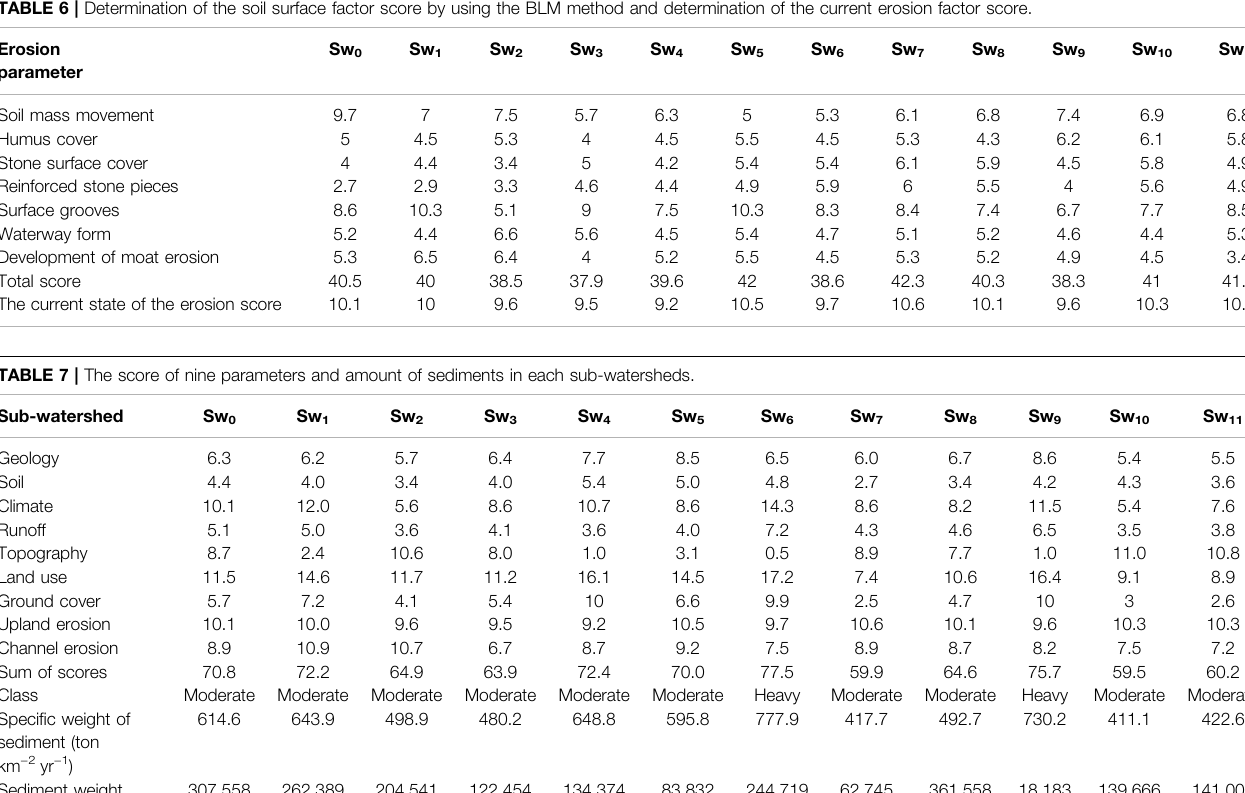
TABLE 6 | Determination of the soil surface factor score by using the BLM method and determination of the current erosion factor score. Erosion